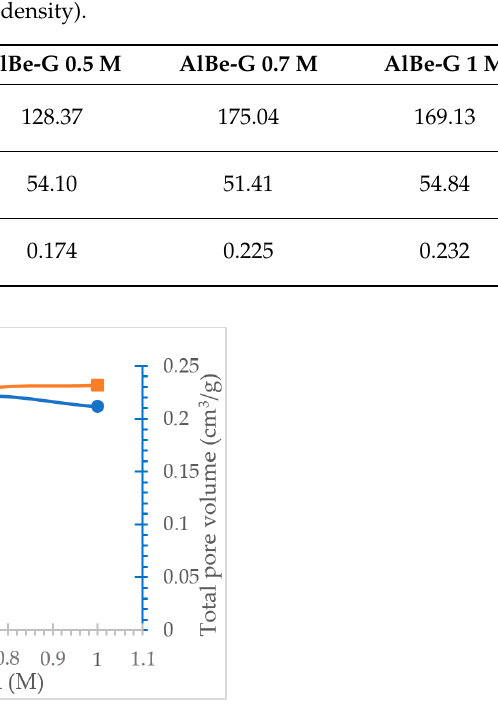
Figure 6. Pore size distribution of AlBe-G samples (80 °C; acid concentrations of 0.5 M, 0.7 M and 1 M; 2% of pulp density). 3.4. Oxalic Acid Activated Ferruginous Smectite In the FT-IR spectra of the FeBe-I raw and activated samples (Figure 7a), the bands at 1030 cm − 1 and 1012 cm − 1 are assigned to the Si-O stretching band [9]. There are also two bands for calcium oxalate at 1627 cm − 1 and 1318 cm − 1 . The intensity of the bands at 3623 cm − 1 and 3696 cm − 1 reduces with acid treatment due to the removal of the hydroxyl groups connected to the octahedral atoms that are leached out from the smectite structure [11]. The peaks of Al 2 OH, AlFeOH and AlMgOH gradually decrease as the acid concen- tration increases due to the extraction of octahedral atoms. The AlMgOH band disappears completely after treatment at acid concentrations of 0.5 M or higher, while the AlFeOH disappears with treatment at 1 M (Figure 7b), in contrast to the Al band, which remains intense. These observations are confirmed by the metals’ extraction diagrams (Figure 3),